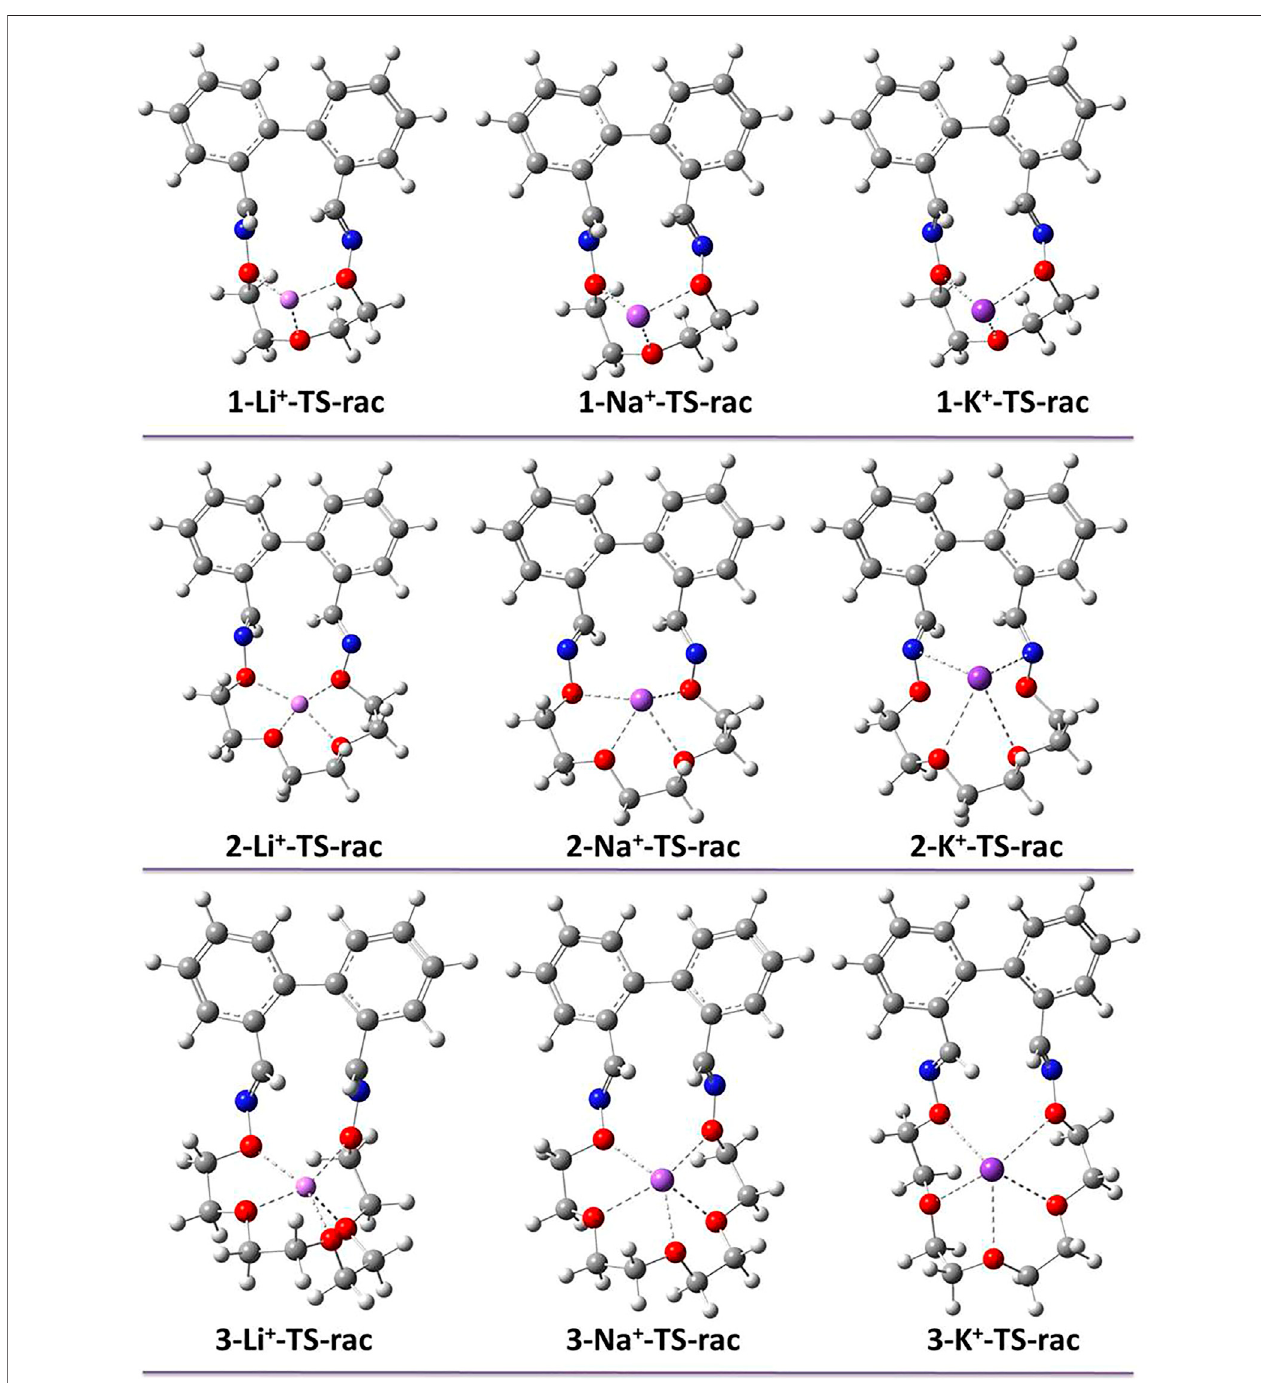
FIGURE 7 | Optimized TS geometries of complexed macrocycles 1 –